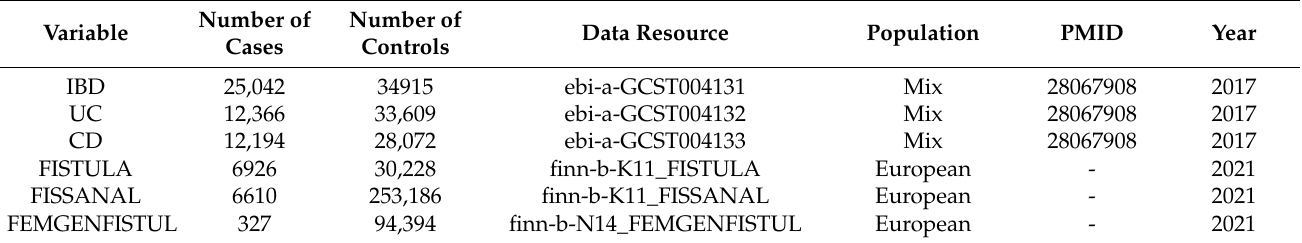
Table 1. Detail of the data for the cohort population. (IBD: inflammatory bowel disease; UC: ulcerative colitis; CD: Crohn’s disease; FISTULA: colonic or urogenital fistula, FISSANAL: fissure and fistula of anal and rectal regions; FEMGENFISTUL, fistula involving female genital